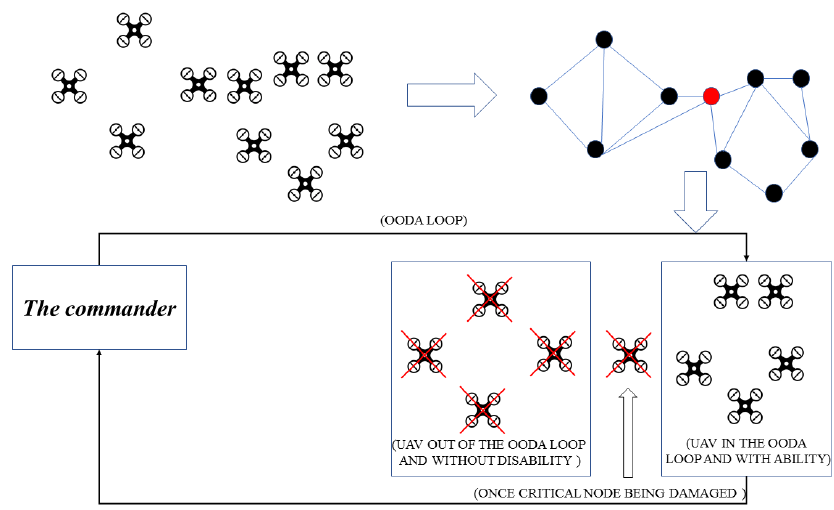
Figure 1. The flow of UAV swarm network disintegration strategy.